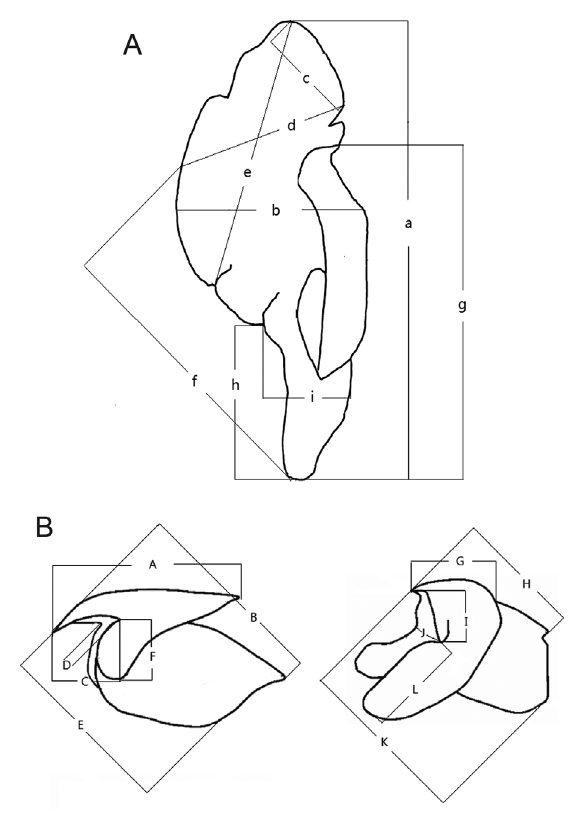
2. – Schematic diagram of statolith (a) and beak (b) morpho- metric variables measured. Upper panel: a is total statolith